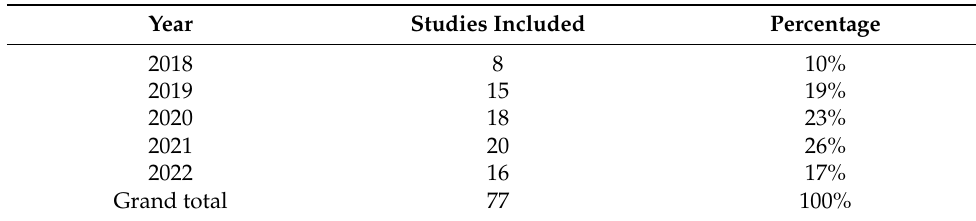
Table 5. Distribution by year of the selected